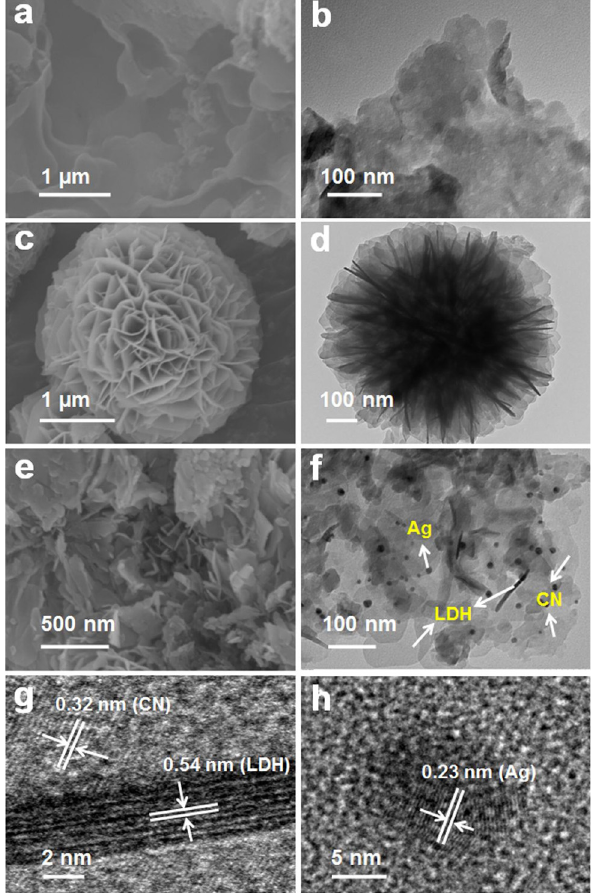
Figure 6: ( a, c, and e ) SEM and ( b, d, and f ) TEM images of CN, LDH, and the ALDHCN - 15 samples, respectively. ( g and h ) High - resolution TEM images of the ALDHCN - 15 nanocomposite. Reproduced with permission from ref. [ 106 ] ; copyright ( 2018 ) ,